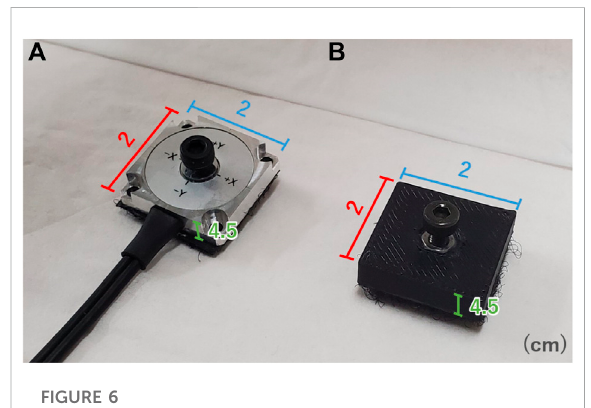
FIGURE 6 (A) 3-axis force sensor, (B) Fixation device.